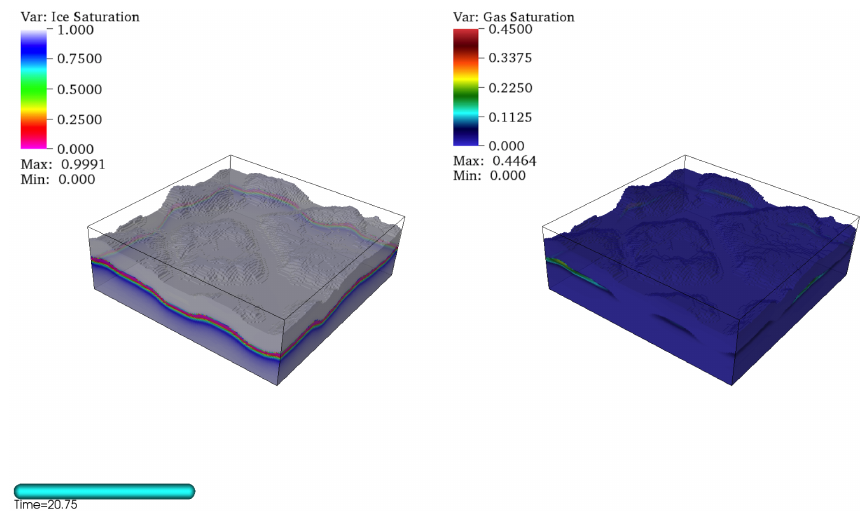
Figure 10. Ice thawing and freezing with seasonal surface temperature variation (continued). Ice and gas saturations for peak fall shown here. For the values of parameters used see Fig.